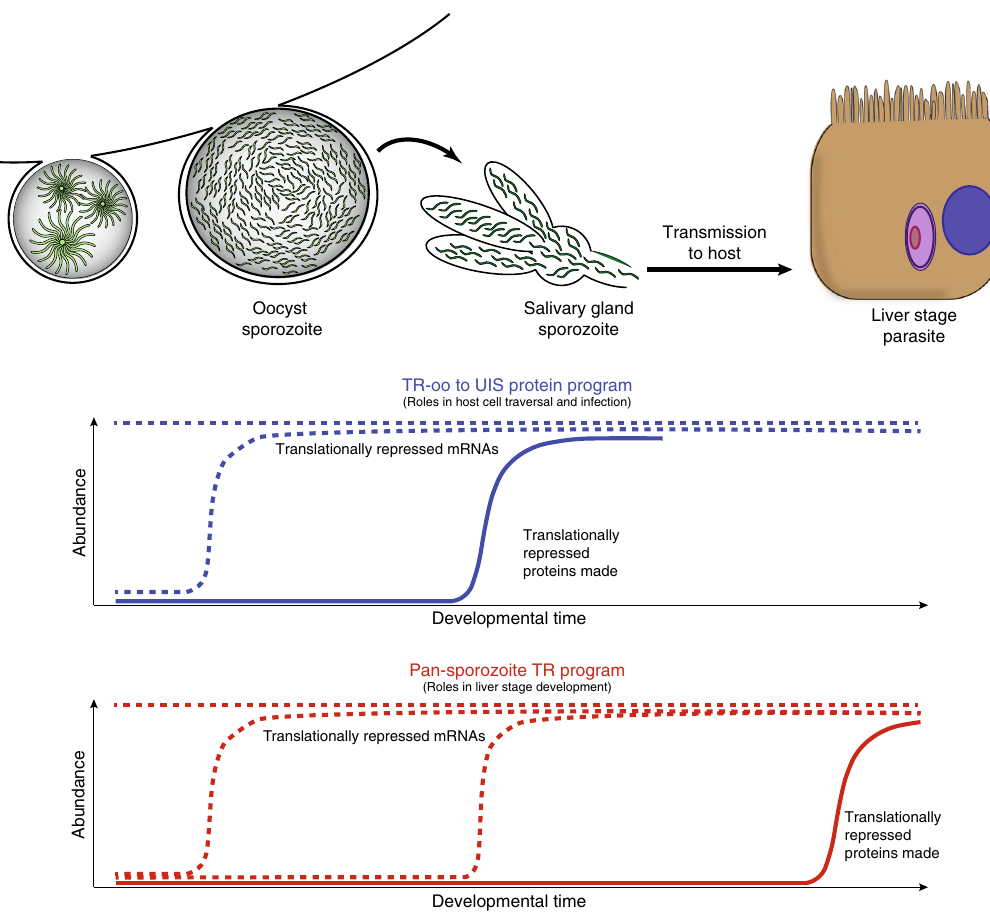
Fig. 5 A model for two independent translational repression programs in Plasmodium sporozoites. One regulatory program acts upon mRNAs that are highly abundant in oocyst sporozoites to impose translational repression, which is relieved in salivary gland sporozoites and enables protein translation to occur. Transcripts encoding for proteins important to host cell traversal and initial infection are regulated in this manner. A second regulatory program translationally represses mRNAs throughout sporozoite maturation, which is hypothesized to be relieved following transmission and infection of